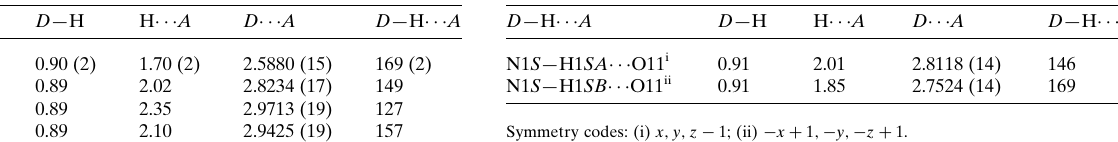
Table 3 Hydrogen-bond geometry (A˚ , (cid:4) ) for 3 .